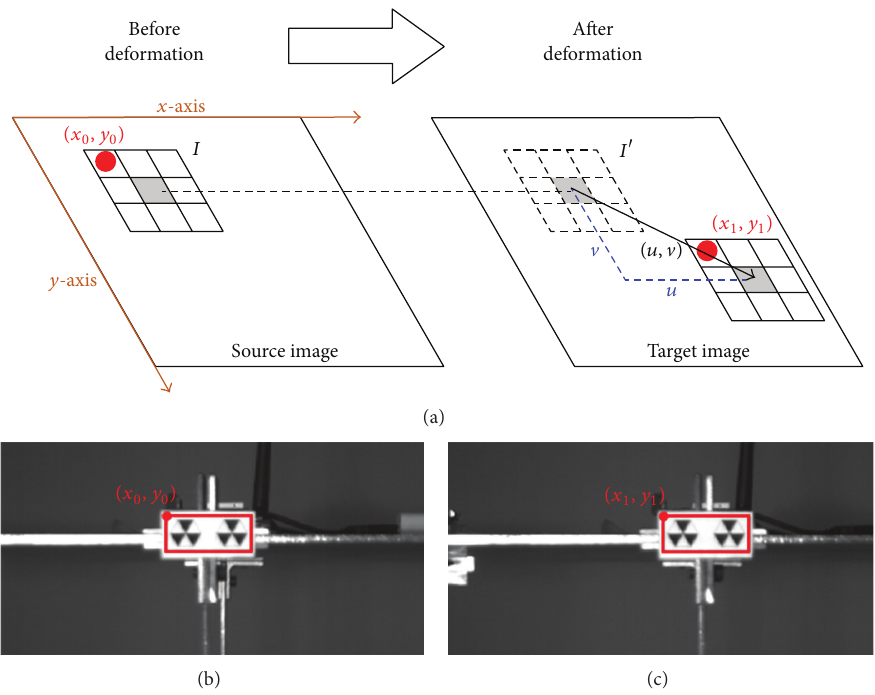
Figure 1: (a) Simplified diagram of source and target image, showing displacement variation of image block. (b) Source images. (c) Target image.